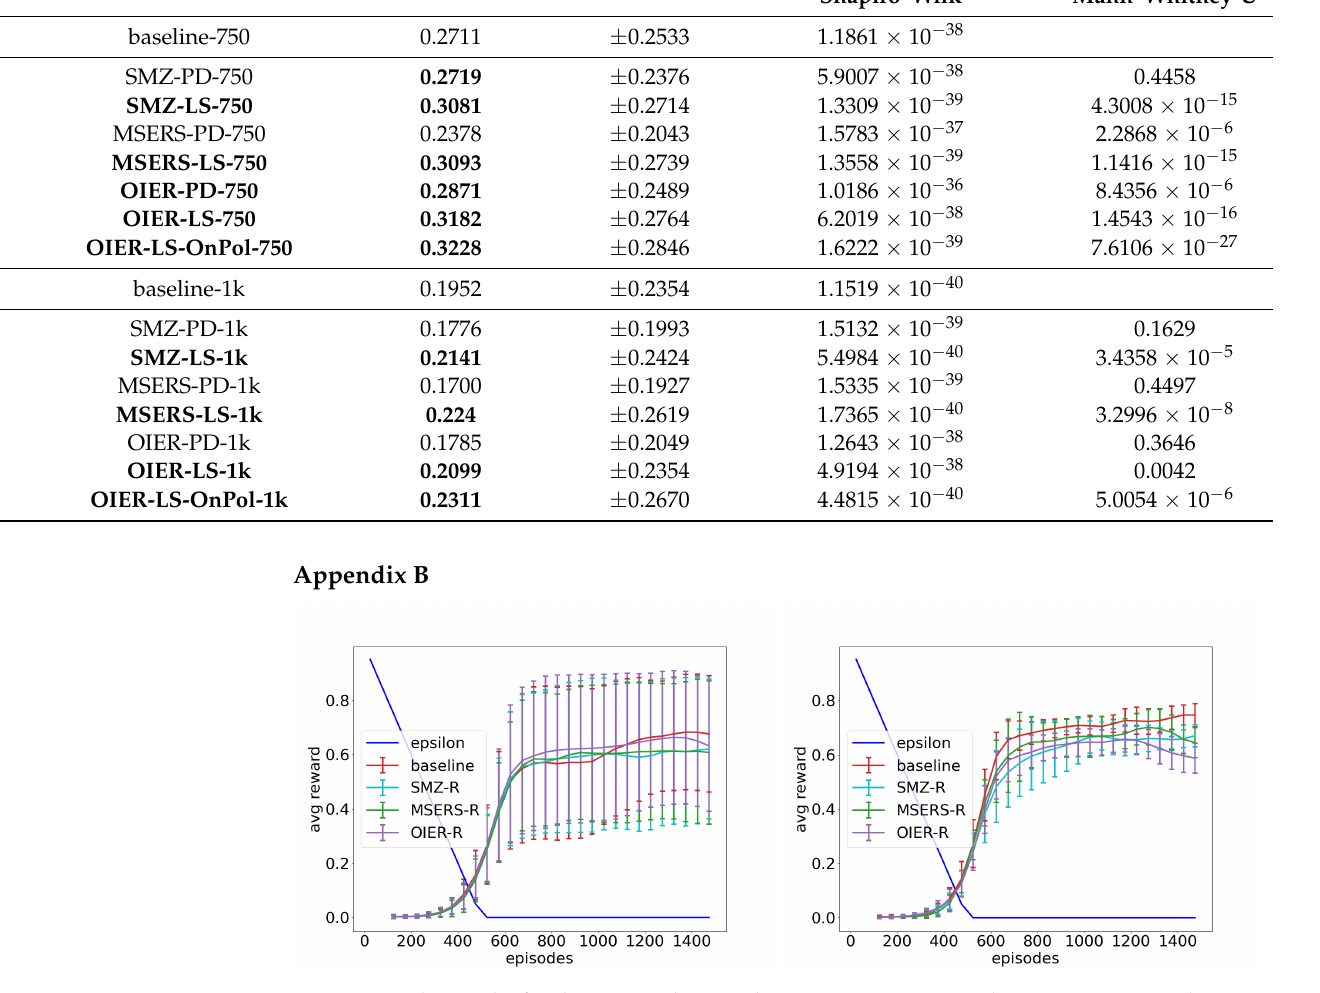
Figure A1. The results for the IER mode: R and t expl = 500. state encoding: VE. state encoding: CE.